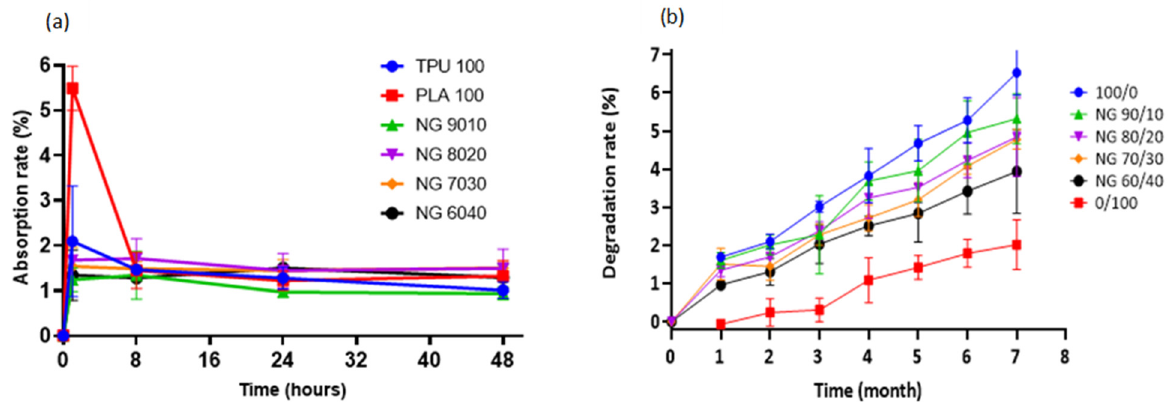
Figure 6. ( a ) Water absorption rate of TPU, PLA, and the blends, ( b ) In vitro degradation study of the samples. Pure TPU shows the fastest degradation rate, while the slowest is that of pure PLA.